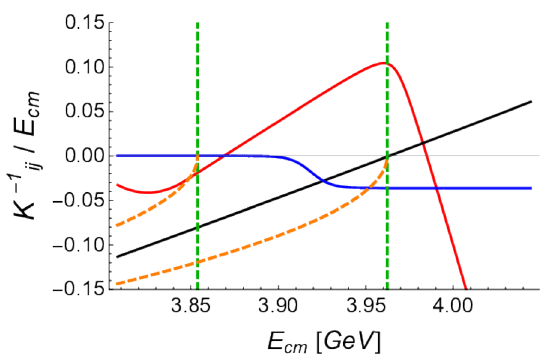
√ Figure 15 . The modeled ˜ K − 1 / s -matrix elements for the coupled D ¯ D − D s ¯ D s scattering: red for D ¯ D → D ¯ D , black for D s ¯ D s → D s ¯ D s and blue for D s ¯ D s → D ¯ D . The green dashed lines indicate the D ¯ D and the D s ¯ D s thresholds. The left orange dashed line gives the bound state constraint for D ¯ D channel. The right orange line gives the bound state constrain for the D s ¯ D s channel in the limit that the two channels are decoupled.